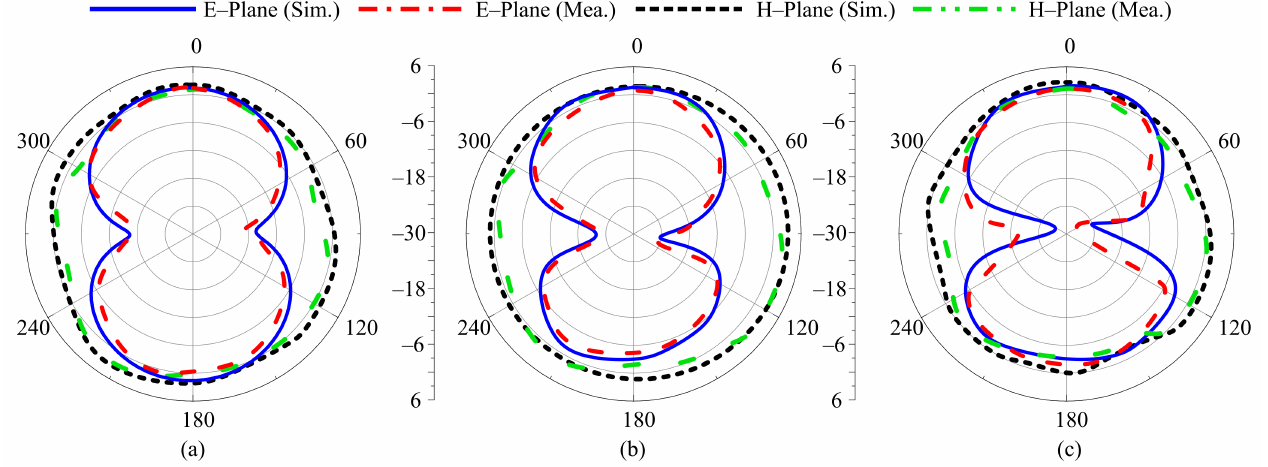
Figure 14. Simulated and measured radiation pattern of proposed antenna at 2.1 GHz for Case-110.